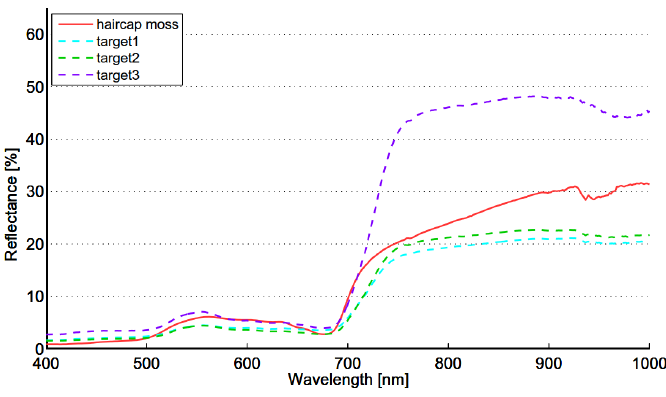
Figure 4. The reference spectrum of haircap moss and the spectra of targets 1–3 measured on 18 July 2012.